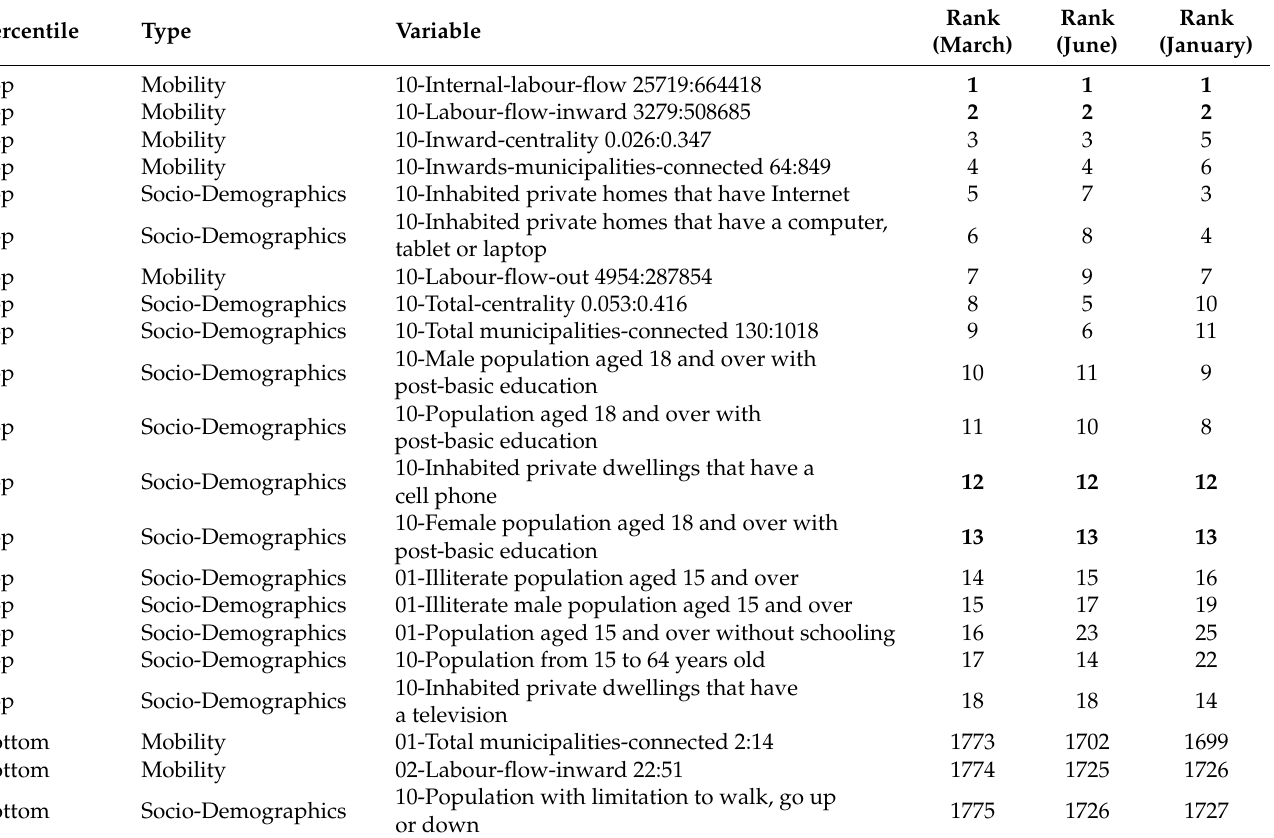
Table 1. Top 18 most niche-like and bottom 18 most anti-niche-like habitat factors for the ENM for top 10% of municipalities with highest number of cases ranked by score in March 2020 and showing the corresponding rank in June 2020 and January